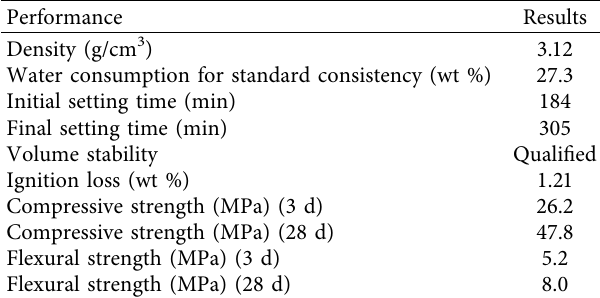
Table 1: Performance of